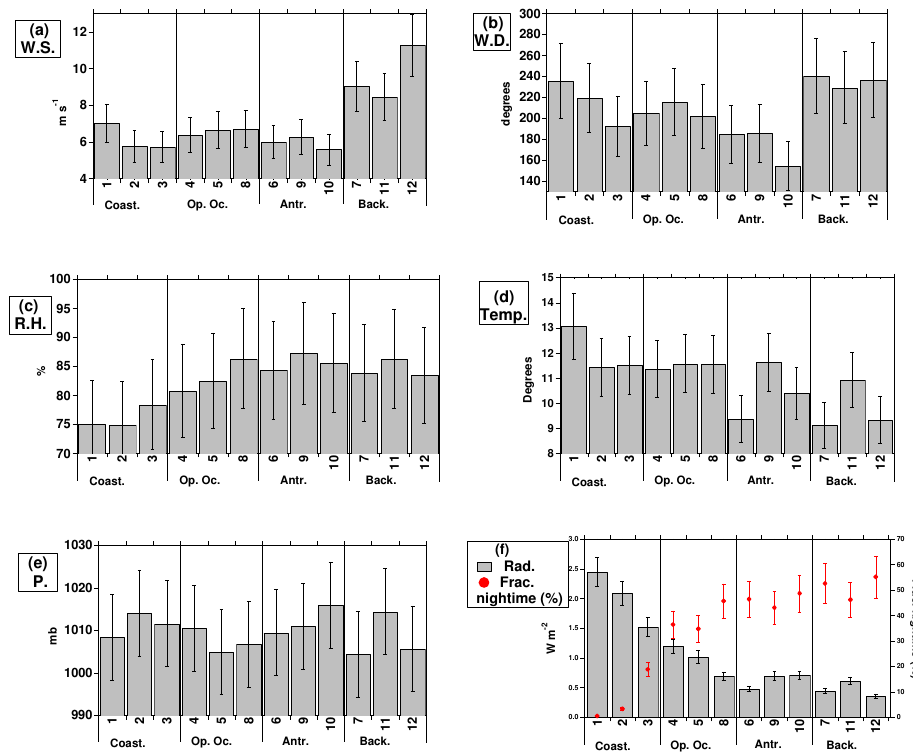
Fig. 4. Average values for each cluster for (a) Wind Speed (ms − 1 ); (b) Wind Direction ( ◦ ); (c) Relative Humidity (%); (d) Temperature ( ◦ C); (e) Atmospheric Pressure (mb) and (f) solar radiation (Jm − 2 , right scale) and percentage of hourly average size distribution detected during night time (%, left scale). Clusters are grouped among the four different groups: Coastal nucleation (Coast.), Open Ocean nucleation (Op. Oc.), Anthropogenic (Ant.) and Background marine (Back.), respectively. Table 1. K-means cluster analysis results and main features of the 12 clusters obtained. The not defined (N.D.) Aitken modes are due to the predominance of the nucleation and/or accumulation modes in some of the aerosol size distributions clusters. Aerosol category cluster